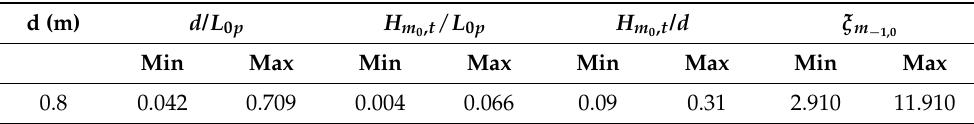
Table 2. Overview of the geometrical and wave parameters tested in the experimental layout.